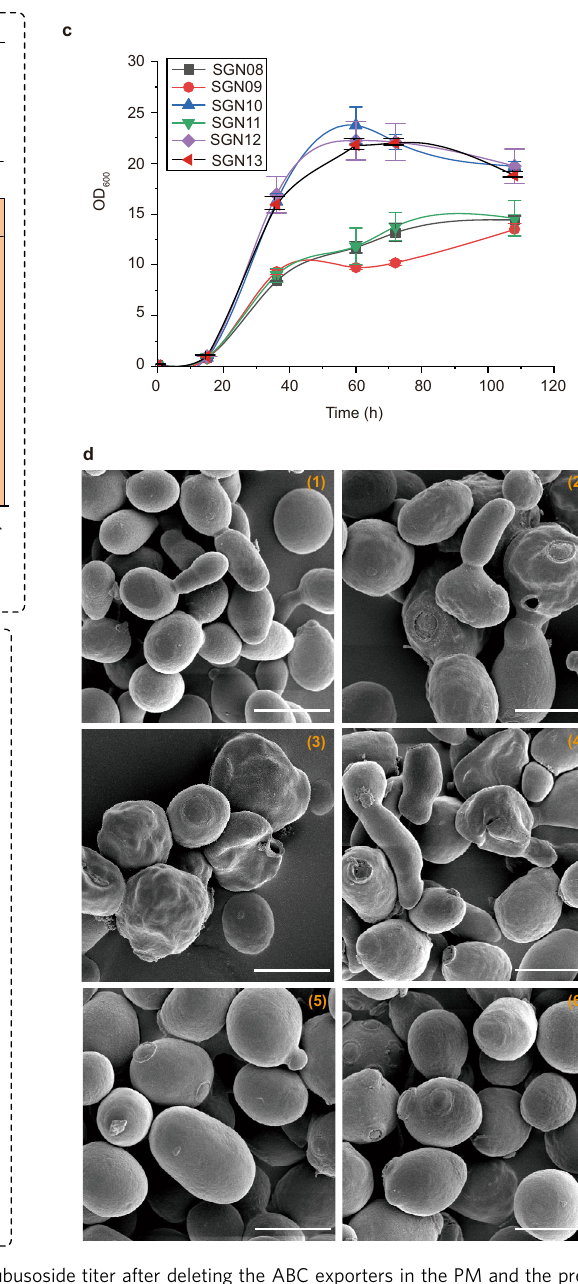
NATURE COMMUNICATIONS| (2022) 13:3040